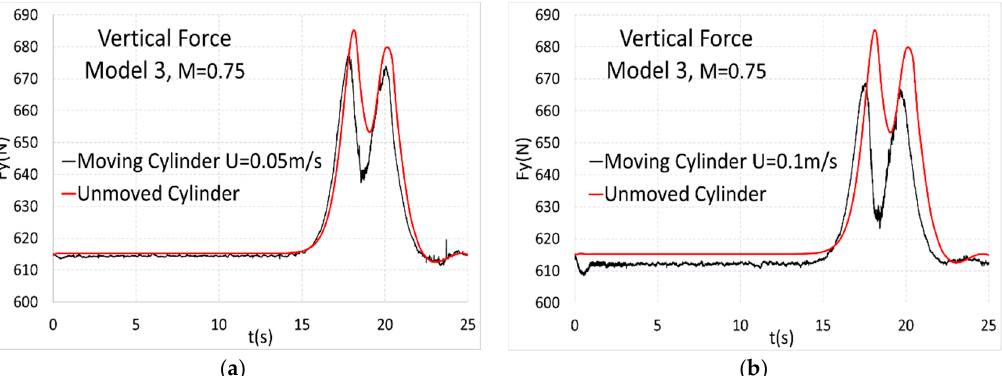
Figure 16. The time variation of vertical forces for model 3. ( a ) The comparison between the unmoved cylinder (red line) and the moving cylinder at U c = 0.05 m/s. ( b ) The comparison between the unmoved cylinder (red line) and the moving cylinder at U c = 0.1 m/s.